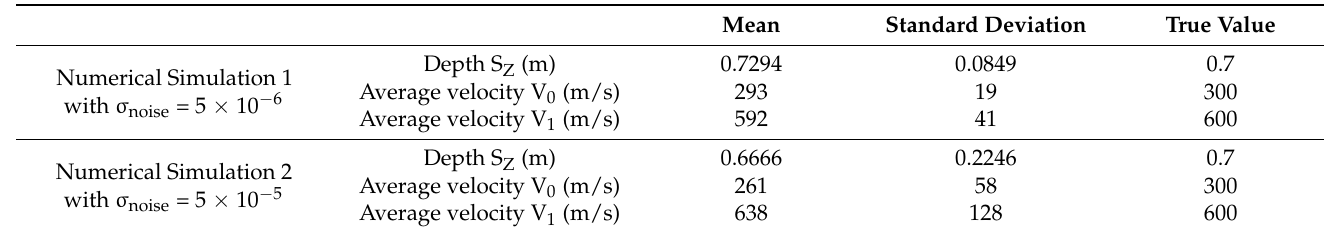
Table 4. Statistics of the MUSIC estimator adapted to Model M2 using the Monte Carlo method in situation 1 (7 sensors spaced 0.2 m apart). Noise is applied to the propagation times, which are in the order of a millisecond.